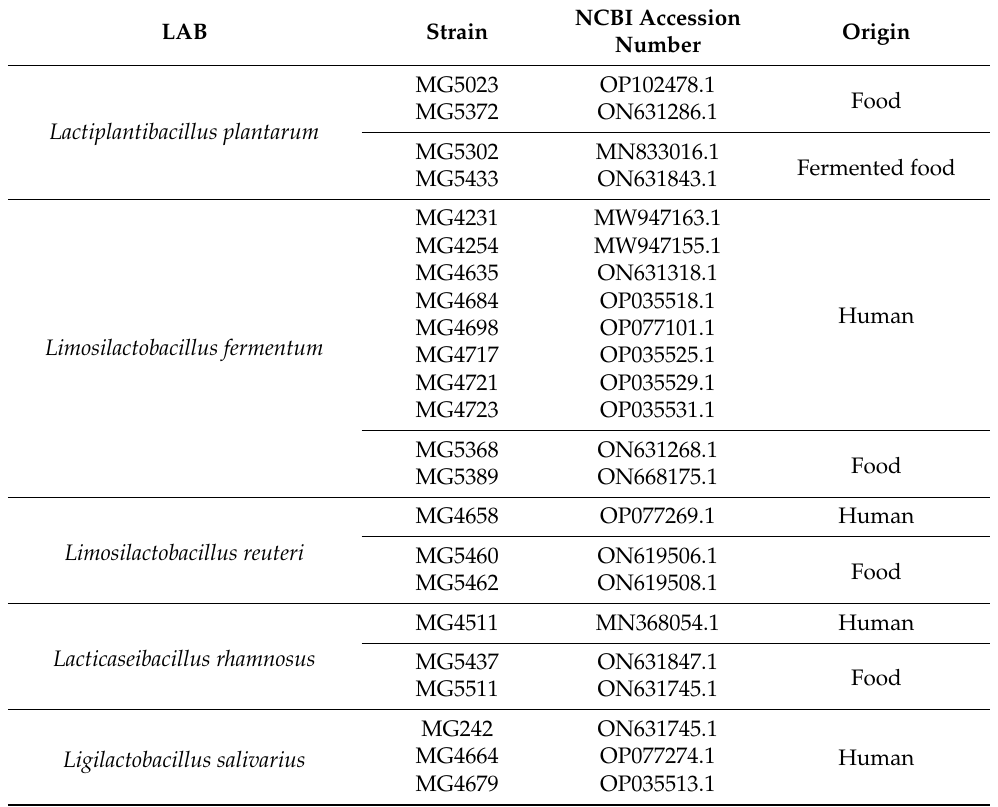
Table 1. Accession number and origin of LAB used in this